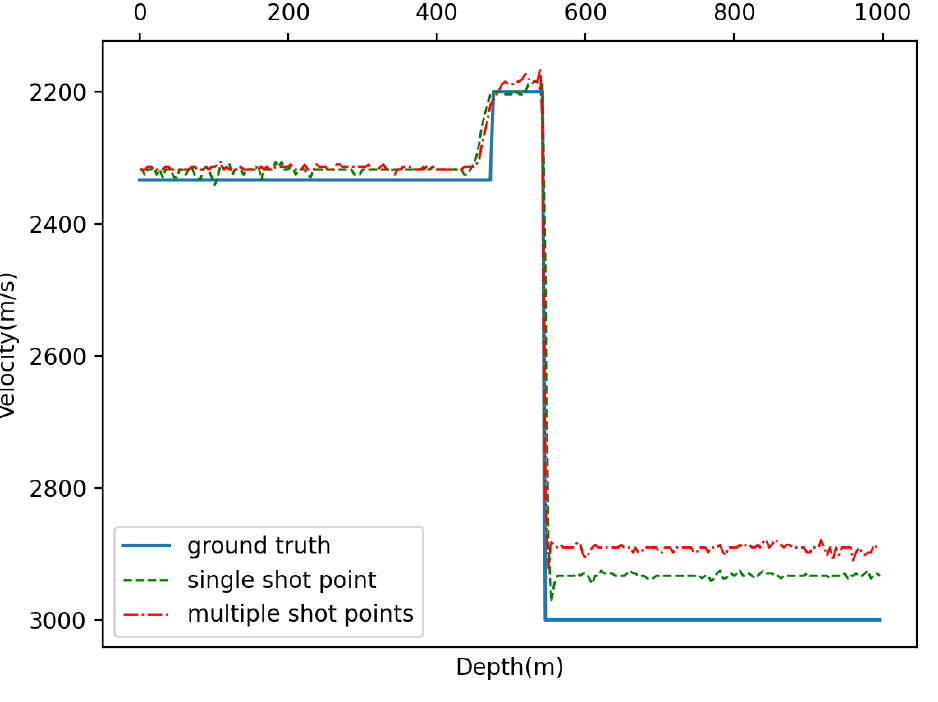
Figure 14. Vertical velocity profiles of velocity field with 2 anomalies and no